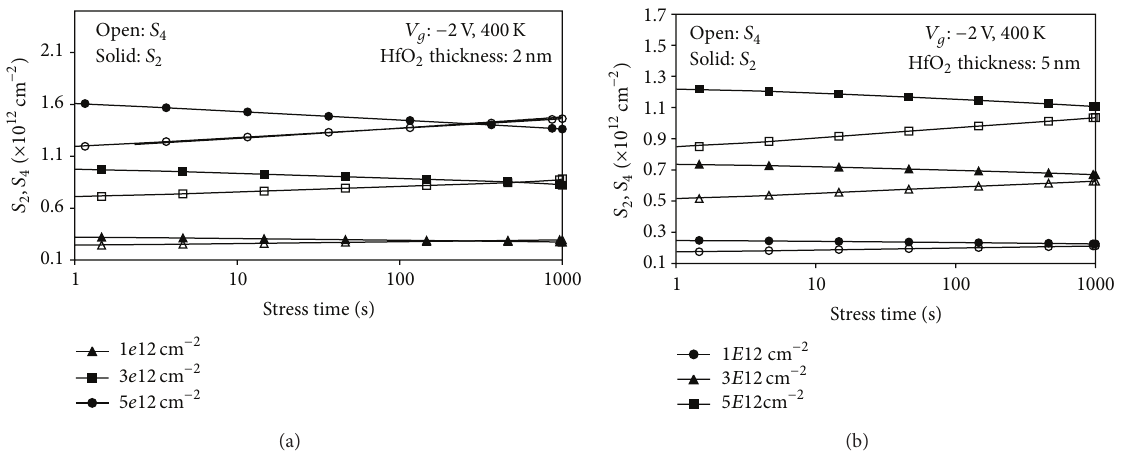
Figure 11: Time evolution for hole trap density, 𝑆 2 , and interface trap density, 𝑆 4 , for a different number of precursors. (a) Thin HfO 2 and (b) thick HfO 2